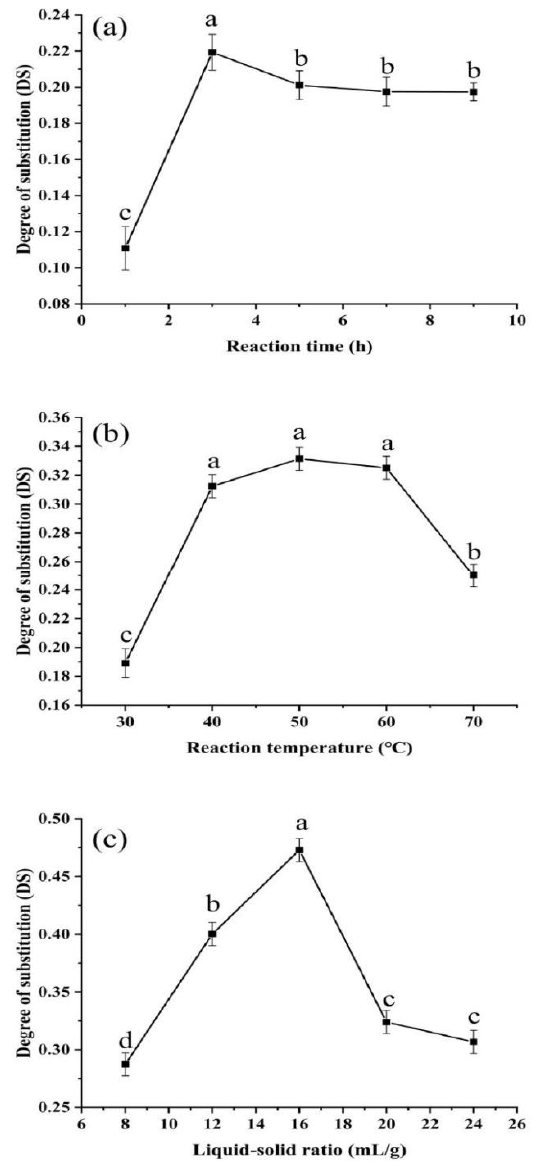
Figure 1. Effect of reaction time ( a ), reaction temperature ( b ), and liquid-solid ratio ( c ) on the degree of substitution of RDPs. Different letters indicate significant differences ( p < 0.05).